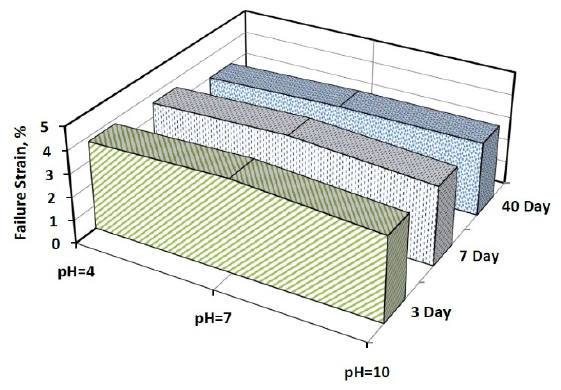
Figure 12: Volume change coefficient of nonstabilized samples in various environments in terms of acidity.